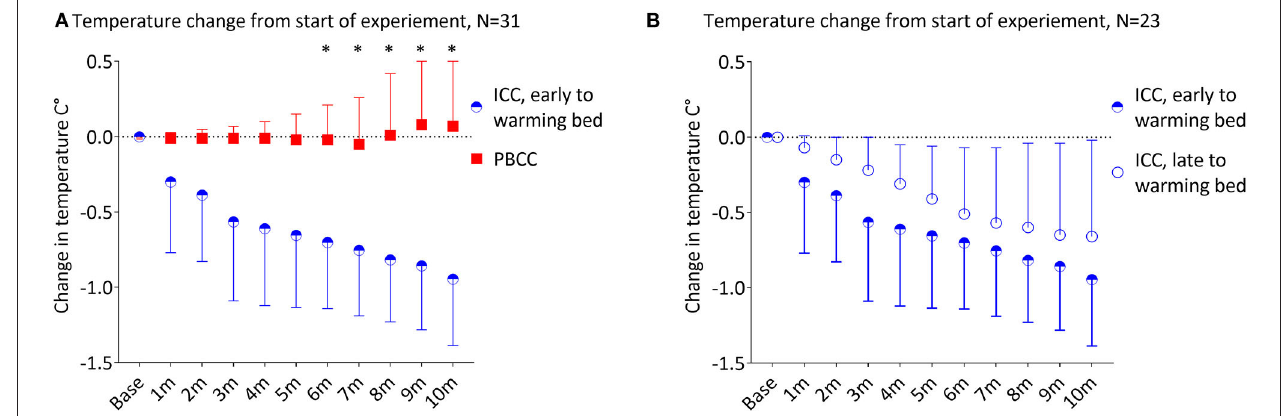
FIGURE 4 | (A) Change in temperature from the start of the experiment in lambs that received immediate cord clamping (ICC) and were transferred to the warming bed early (mean 38 ± 20s after umbilical cord clamping) vs. physiologic-based cord clamping (PBCC) displayed in mean ± SD using two-way mixed ANOVA with Games-Howell post-hoc analysis. (B) Change in from the start of the experiment in lambs that received ICC and transferred to the warming bed early (mean 38 ± 20s after umbilical cord clamping) vs. late (mean 412 ± 178s after umbilical cord clamping) displayed in mean ± SD using two-way mixed ANOVA with Games-Howell post-hoc analysis. ICC, immediate cord clamping; PBCC, physiological based cord clamping; m, minutes, *denotes significant difference ( p < 0.05) in temperature between